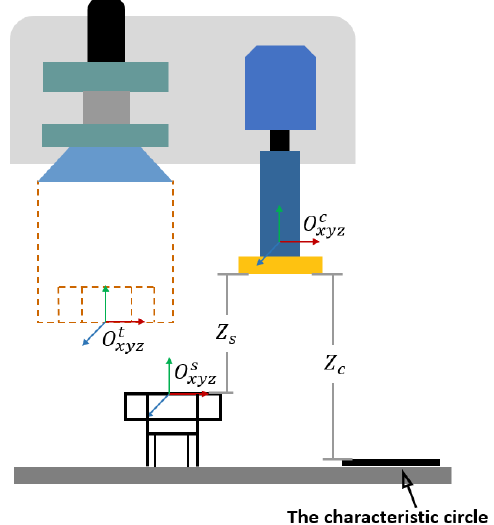
Figure 18. Locations of centers of the screw, tool frame, and camera frame. (2) Engagement motion guided by robot : In real situations, the bottom of loose screws